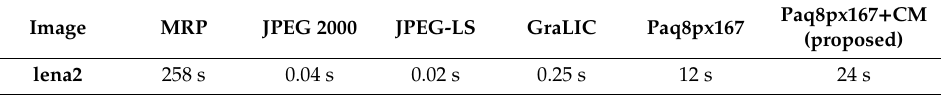
Table 5. Compression running time comparison on image lena2 (expressed in